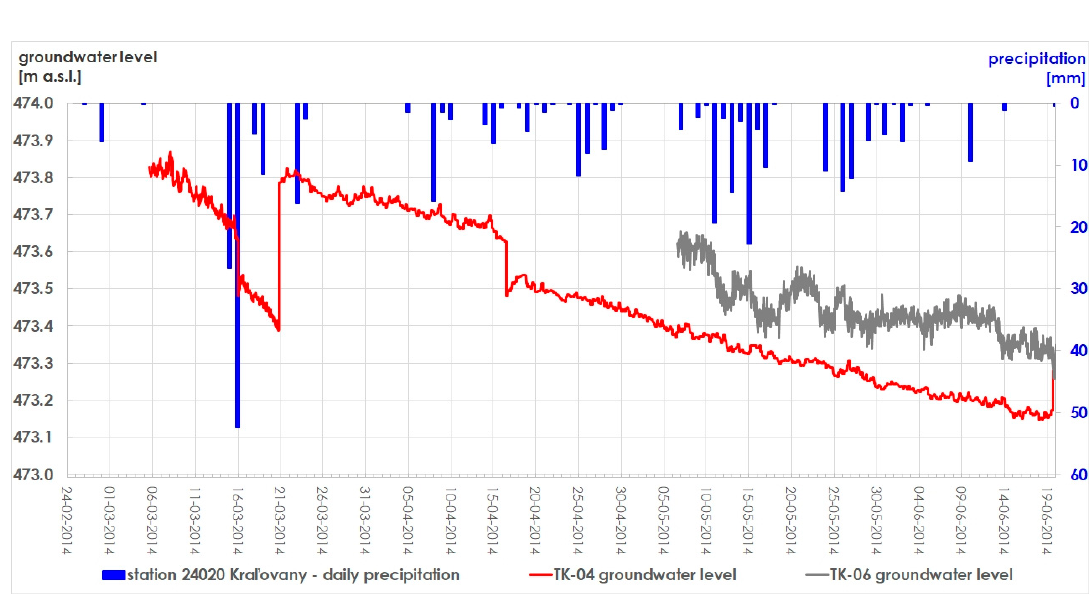
Figure 6. Groundwater levels in TK-04 and TK-06 boreholes and daily precipitation totals at the SHMI 24020 station Kra ľ ovany in the period of 24.02.2014–20.06.2014.